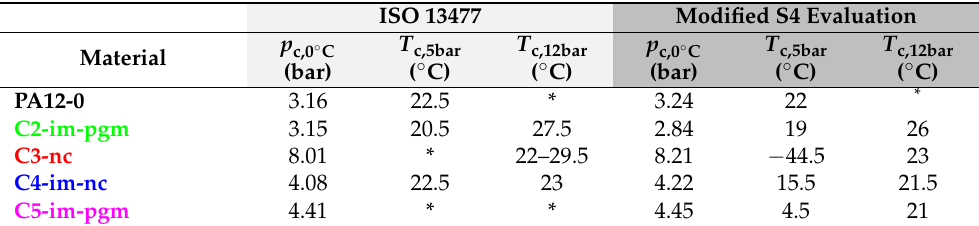
Table 2. Standard evaluation according ISO 13477 vs. modified evaluation of S4 test